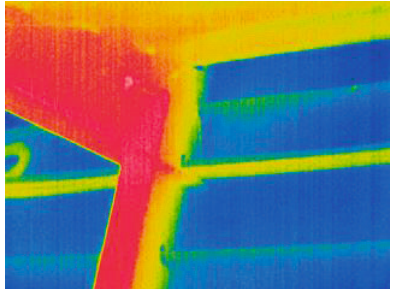
Figure 9. Thermovision photo of girder interior (cf. Figure 8). The photo taken on 31 March 2019 at about 23:00. Blue colour denotes cooler areas than those in yellow or red. Plates of the slanted wall of the girder dissipate heat outside faster than internal constructional elements like